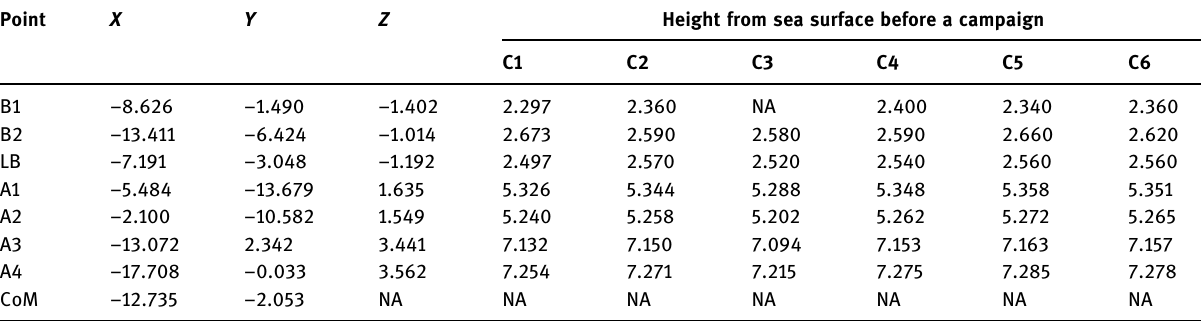
Table 5: Local ( in an arbitrary reference frame ) coordinates of the vessel ’ s center of mass ( CoM ) , GNSS ARPs ( A1, A2, A3, and A4 ) , and benchmarks ( B1, B2, and LB ) on the vessel ’ s railing, as well as heights of these points above sea surface before the campaigns Point